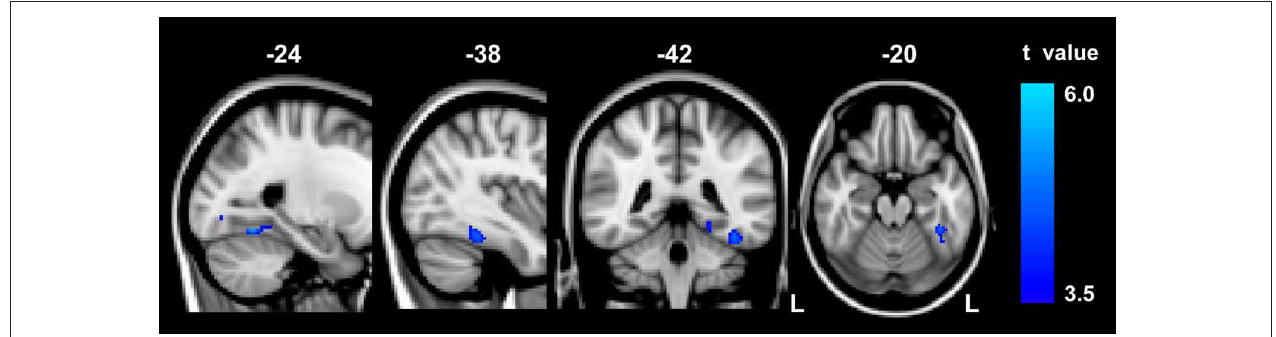
FIGURE 1 | The result of between-group VBM comparison in the left FG. Decreased gray matter volume was detected in the abacus-trained group relative to the controls ( p < 0 . 01, FDR corrected). The bar to the right indicates the t score level. L, left.